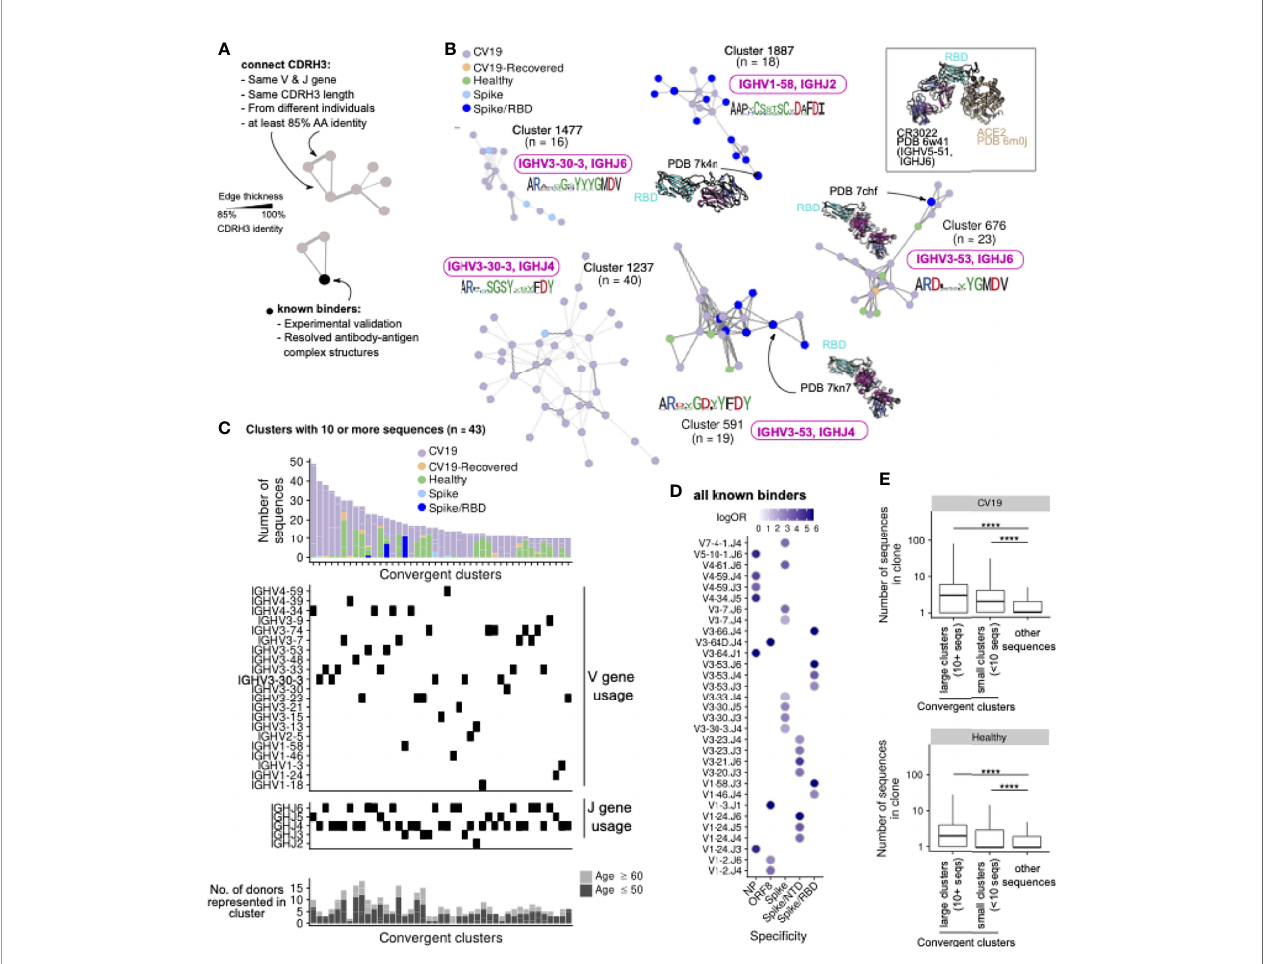
FIGURE 3 | CDR3 regions from different CV19 patient repertoires converge, some with known SARS-CoV-2 binders. (A) CDR3 known binder networks were created using same V, J and CDR3 length with at least 85% amino acid (AA) identity. (B) Convergent clusters from healthy and CV19 repertoire with known PDB structures. IGHV and IGHJ use and the CDR3 AA sequence were noted. (C) Clusters containing at least 10 sequences were visualized, with breakdown of repertoire origin (stacked bar plots), and the IGHV and IGHJ gene usage of each cluster aligned beneath. The number of donors with sequences in each depicted cluster are shown as bar graphs (bottom panel, C ), broken down into subsets with age ≤ 50 (light grey) and ≥ 60 (dark grey). (D) All known binders were analysed for similarity of IGHV /J gene use to speci fi c SAR-CoV-2 antibody targets. Dots coloured by enrichment (log-odds ratio, logOR). For each V/J combination only the target with the top logOR metric was shown. (E) Comparison of clonal expansion of convergent (split by clone size; ≥ 10 or <10 sequences) and non-convergent clusters in healthy and CV19 repertoires. Statistical signi fi cance evaluated using a Wilcoxon rank-sum test, ****: FDR < 0.0001. See Supplementary Figure S7 for analogous analyses on RSV and EBOV